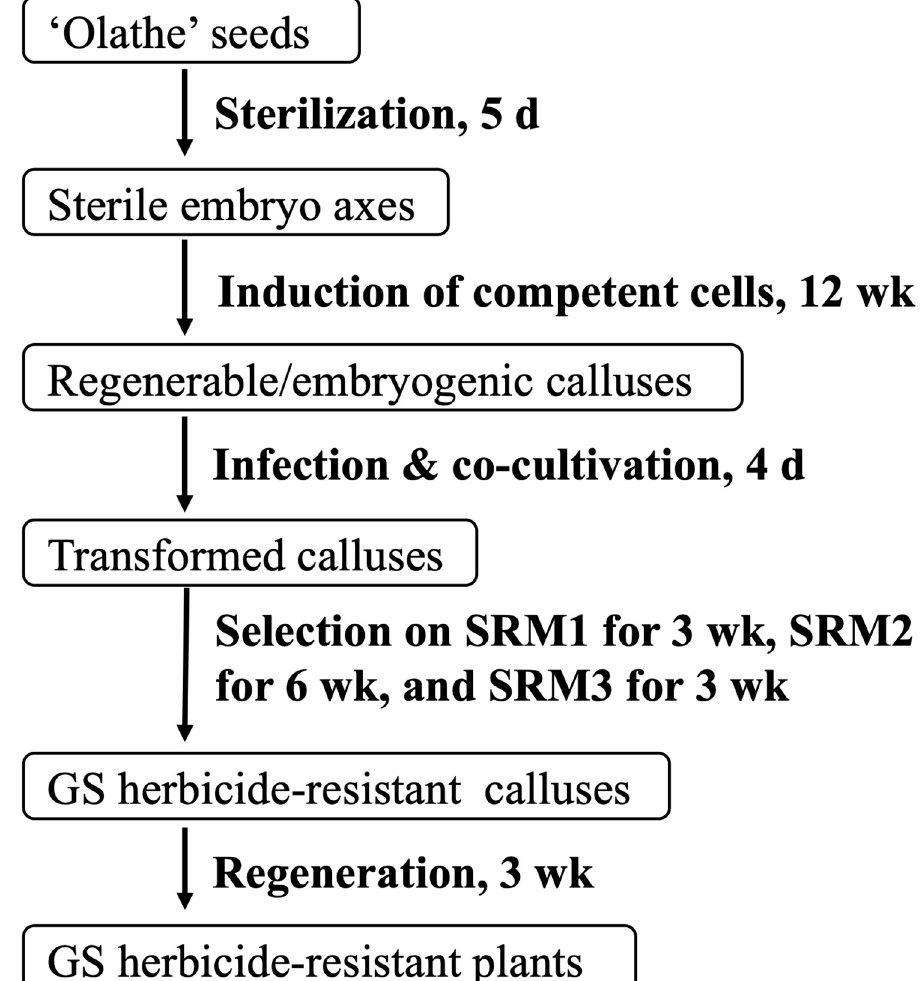
Fig 1. Schematic representation of A . tumefaciens -mediated transformation of ‘Olathe’ pinto bean using competent cells induced from embryo axes.